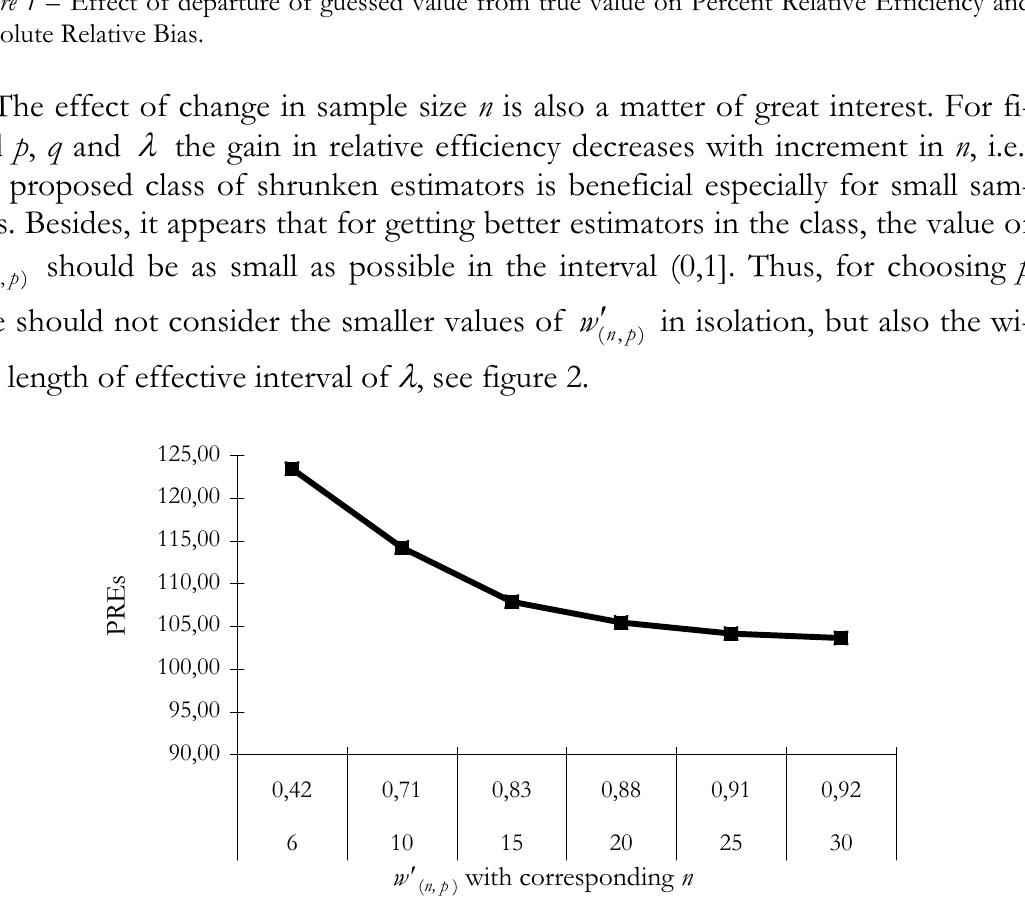
Figure 2 – Effect of sample size on gain in